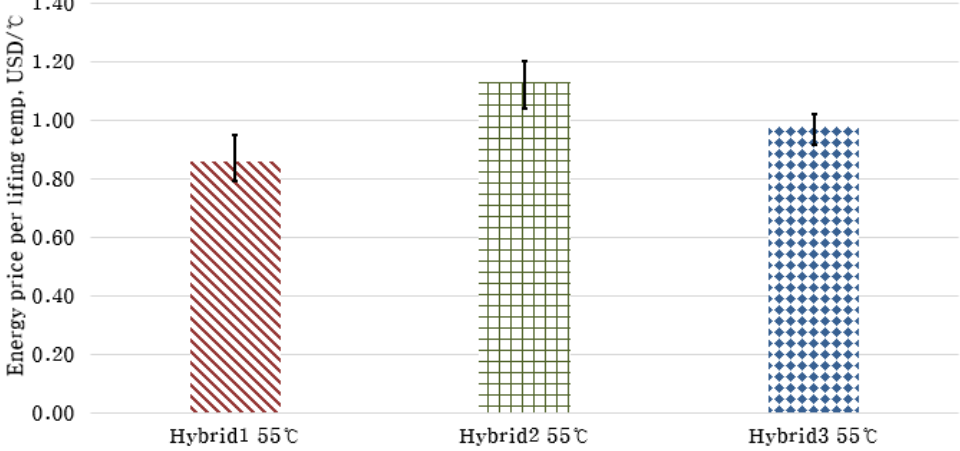
Figure 12. Comparison of average cost of fuel consumption with increasing temperature. Table 8. Statistical analysis results corresponding to the variation of energy consumption with increasing temperature.